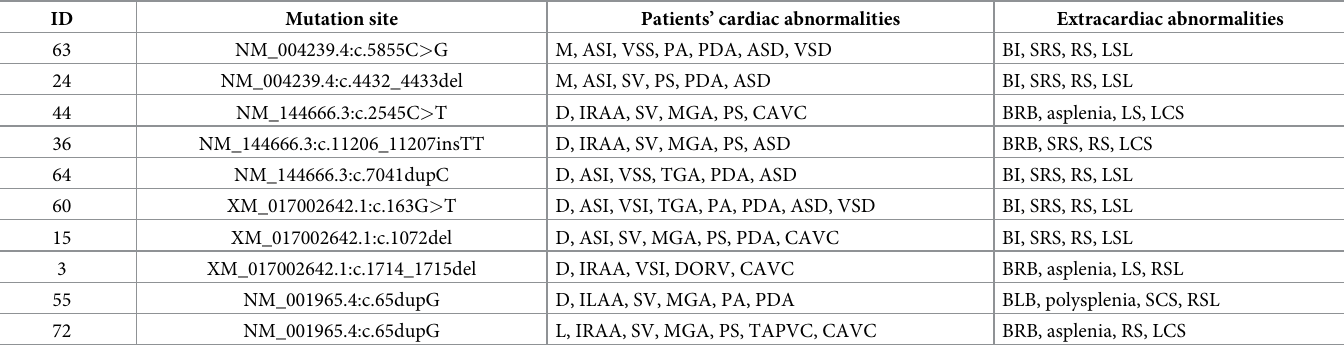
Table 4. Clinical phenotypes of laterality defects patients with LOF variations.